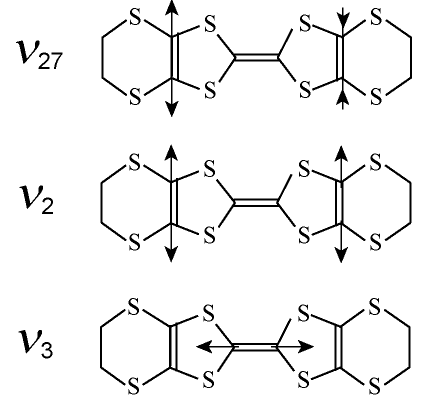
Figure 3. Schematic views of the central C=C bond (wing C=C bonds) has little contribution to